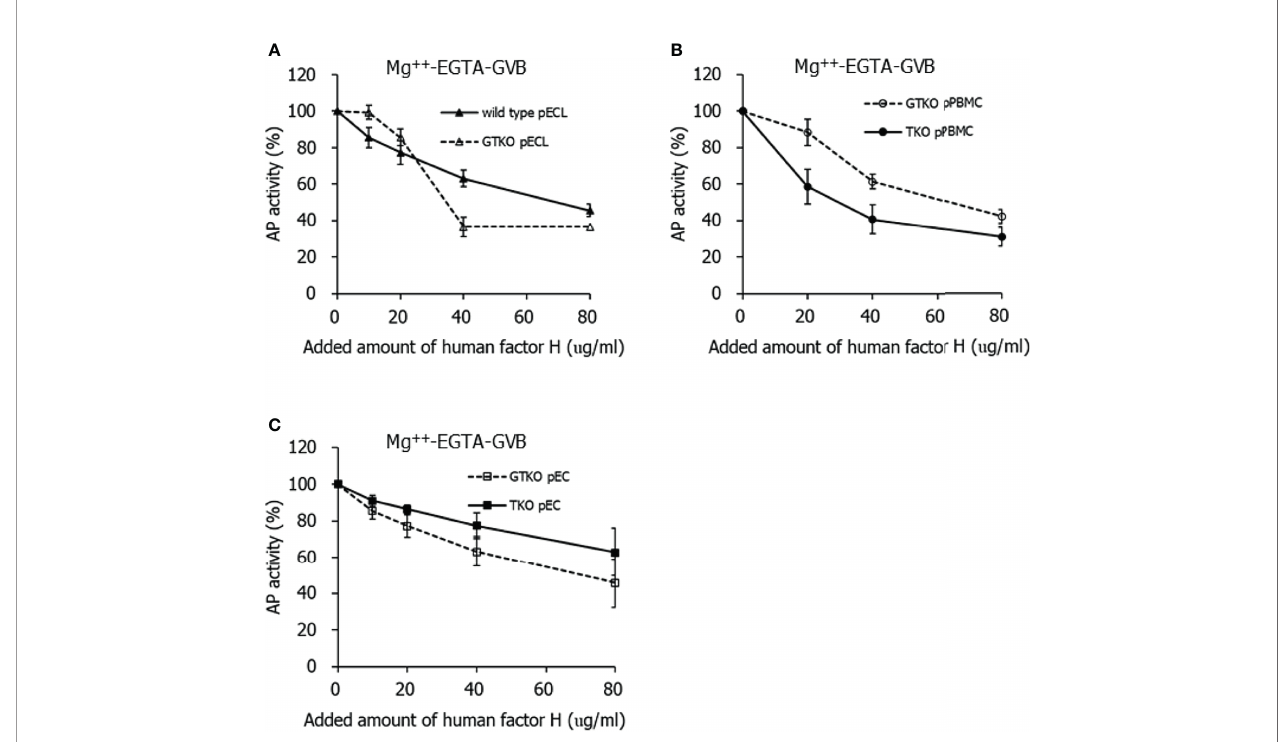
FIGURE 3 | Inhibition of alternative pathway (AP) complement activity on the porcine cells by the addition of human factor H. After incubating in 10% serum diluted in Mg ++ -EGTA-GVB with various concentrations of human factor H, the porcine cells were stained by fl uorescein conjugated anti-C3 antibodies and analyzed using fl ow cytometry. AP activity was determined by C3 deposition on the cells and the percent AP activity of the sample was calculated by comparing it with the AP activity of the sample without factor H assigned as 100%. Wild-type and alpha-1,3-galactosyltransferase gene-knockout ( GT KO) porcine endothelial cell lines ( pECL, A) , peripheral blood mononuclear cells ( PBMC, B) , and primary porcine endothelial cells ( pEC, C) from GT KO pigs and from triple knockout (TKO) pigs were used in the